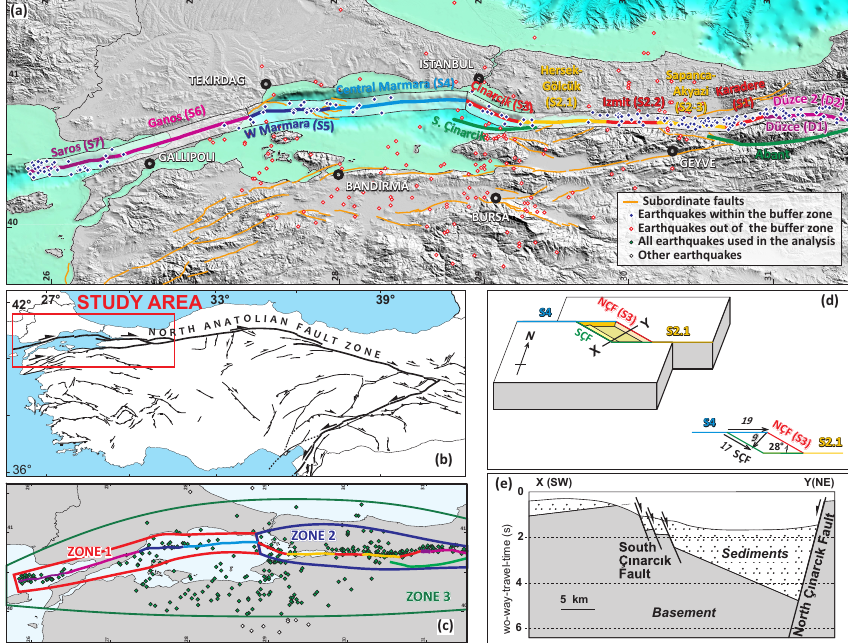
Figure 1. (a) Major branches of the North Anatolian fault zone, defined rupture systems and the instrumental seismicity ( M w > 4) in the study area. The buffer zones used for source-to-epicenter matching are shown around the rupture systems. (b) Simplified active tectonic scheme of Turkey (modified from Emre et al., 2013). Thick lines are the North Anatolian and East Anatolian fault zones; thin lines are other active faults. (c) Distribution of the declustered seismicity used to calculate the b values. Zone 1, Zone 2 and Zone 3 are the polygons used to calculate the b values. (d) Slip distribution model for the Çınarcık segment. Right bending of the northern Çınarcık segment is 28 ◦ with respect to the central Marmara and Hersek–Gölcük segments. This results in a 17mmyr − 1 slip along the northern Çınarcık segment (NÇF) and 9mmyr − 1 normal slip transverse to the fault. This 9mmyr − 1 slip is the total slip on the northern and southern Çınarcık faults (SÇF). (e) Simplified geometries of the Çınarcık faults delimiting the Çınarcık Basin based on seismic profile of Laigle et al. (2008) almost passing through the line XY